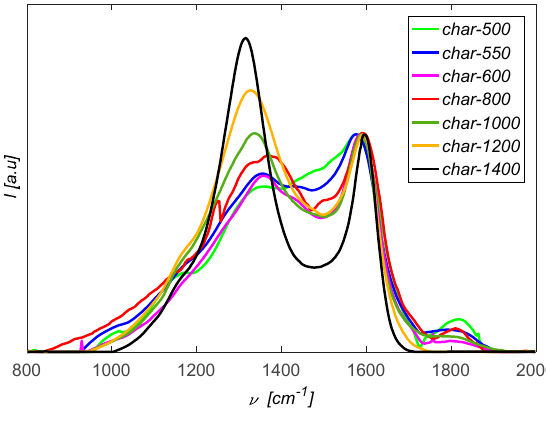
Figure 8. Raman spectra of the pyrolysis solid residues.